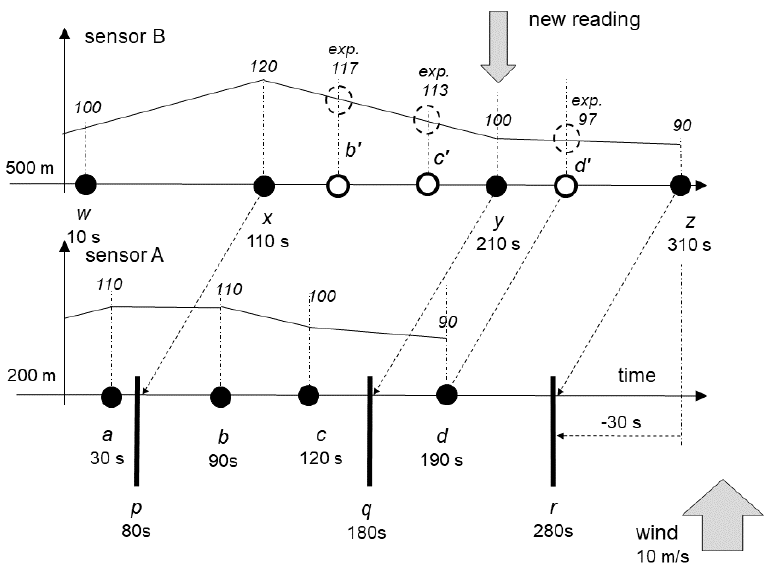
Figure 2. An example of the operation of the NUT (network-uncertainty-trust) model.